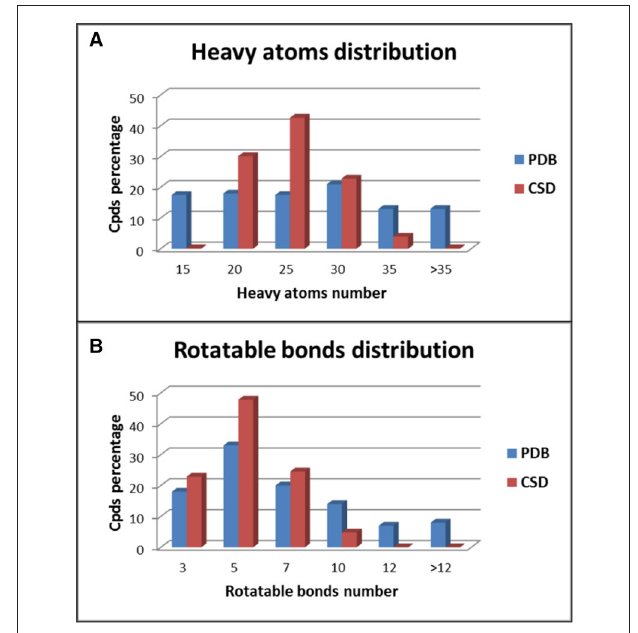
FIGURE 2 | Distribution of heavy atoms (A) and rotatable bonds (B) among PDB and CSD